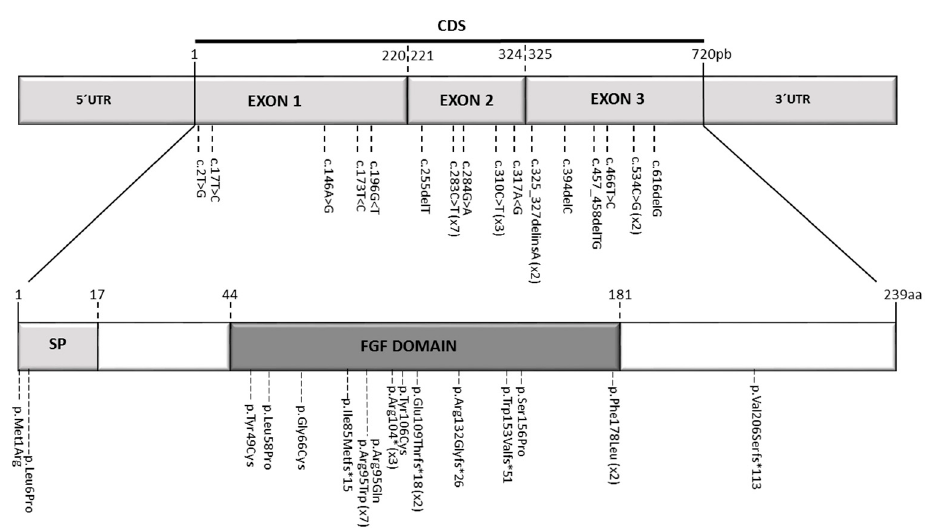
Figure 3. Mutational spectrum in the human FGF3 gene responsible for LAMM syndrome and its correlation at protein level. The mutation notation at DNA level is referred to the coding sequence (CDS, position 1 to 720), thus the position +1 corresponds to the adenine of the initiation codon (ATG) and the position 720 corresponds to the guanine in the last position of the stop codon (TAG). 5 ′ UTR = 5 ′ Untranslated region in exon 1; 3 ′ UTR = 3 ′ Untranslated region in exon 3; SP = signal peptide (1 to 17aa); FGF domain (44 to 181aa). Number coordinates and protein domains were obtained from the NCBI reference sequences NM_005247.4 (nucleotide) and NP_005238 (protein), respectively.